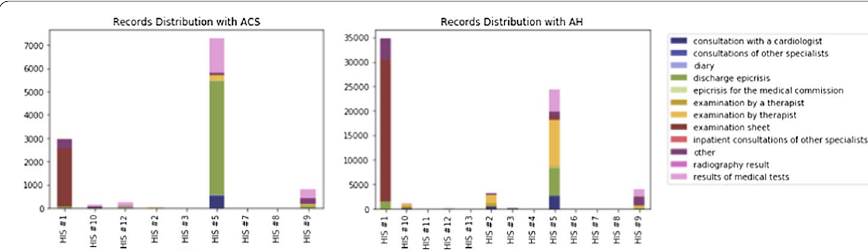
Fig. 11 Distributions of record types for patients with arterial hypertension (AH) and acute coronary syndrome (ACS) with OPTICS labeling